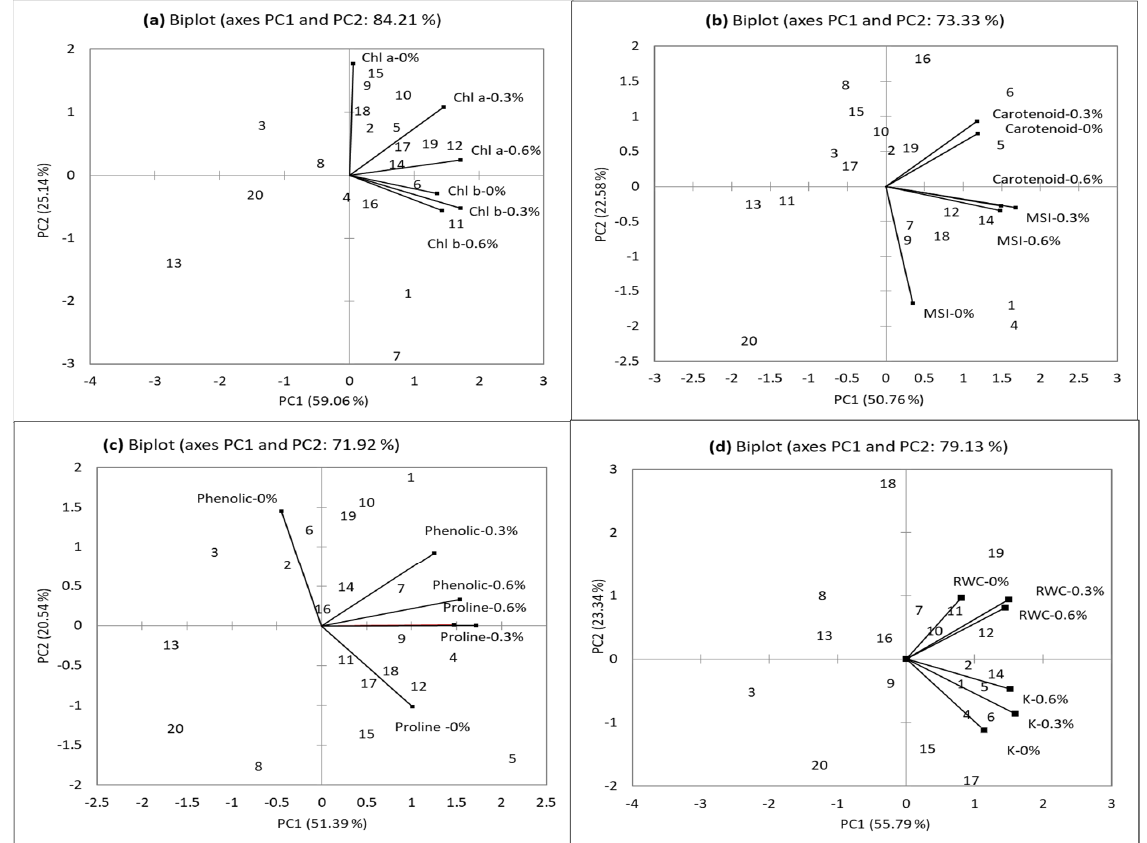
Figure 2. A “Which is best for what” vector view of genotypes by physiological traits such as ( a ) Chl a , Chl b ; ( b ) carotenoid, MSI; ( c ) leaf phenolic, leaf proline; and ( d ) RWC, leaf K + accumulation, under varying water deficit conditions. See Table 1 for codes of the genotypes.